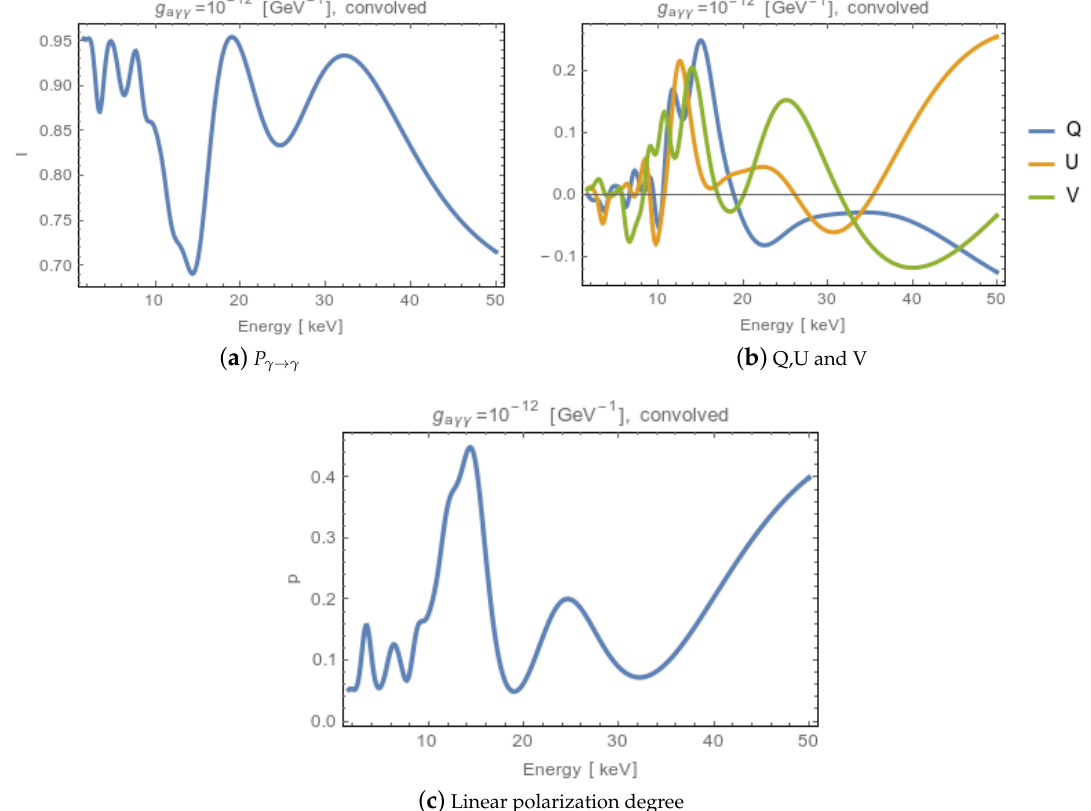
Figure 1. The photon survival probability; ( a ) Stokes parameters ( b ) and degree of linear polarization ( c ) for initially unpolarized photons propagating from NGC1275 at the centre of Perseus, assuming the existence of ALPs with g a γγ = 10 − 12 GeV − 1 . The spectra are convolved with an energy resolution of 450